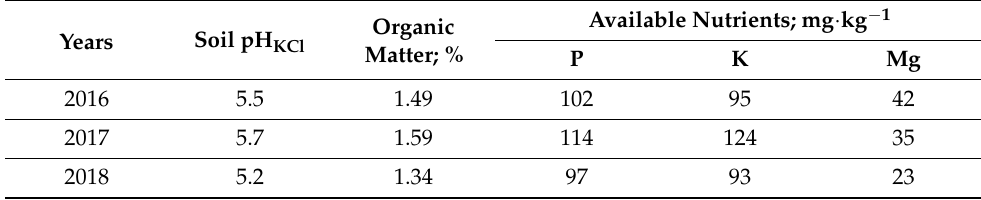
Table 1. Soil chemical properties at the experimental